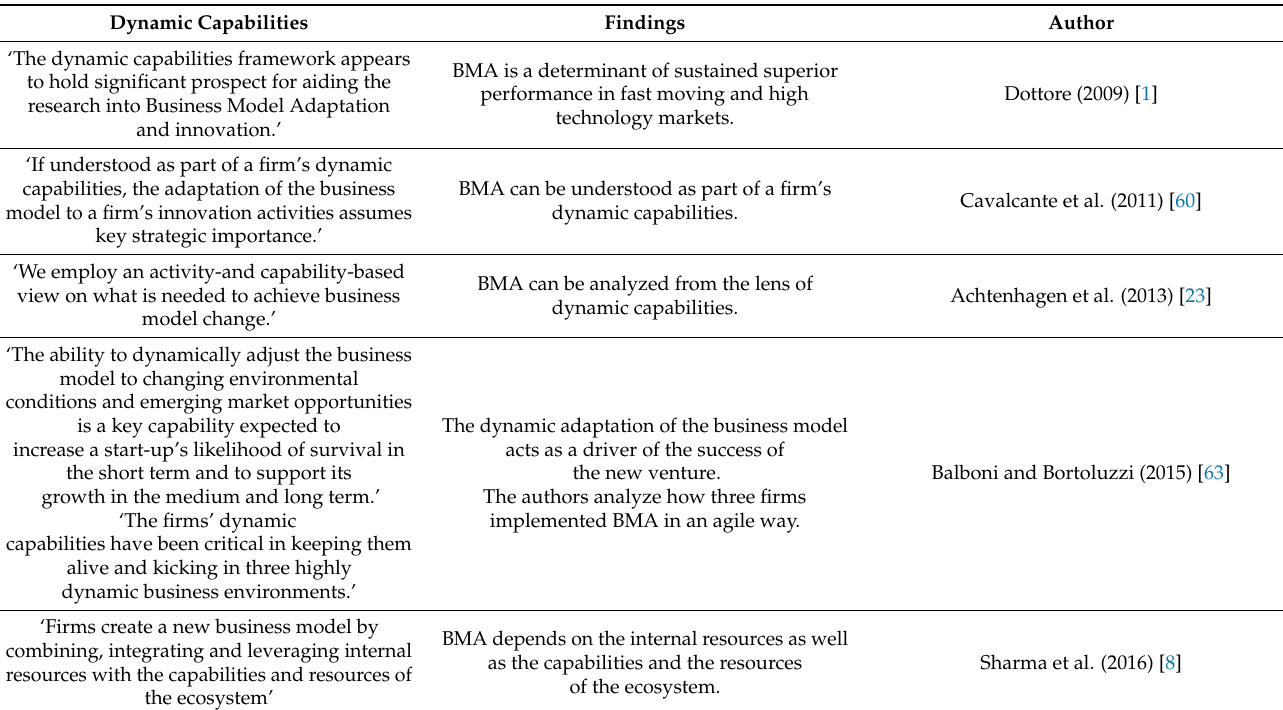
Table 14. Dynamic capabilities view of BMA by core review